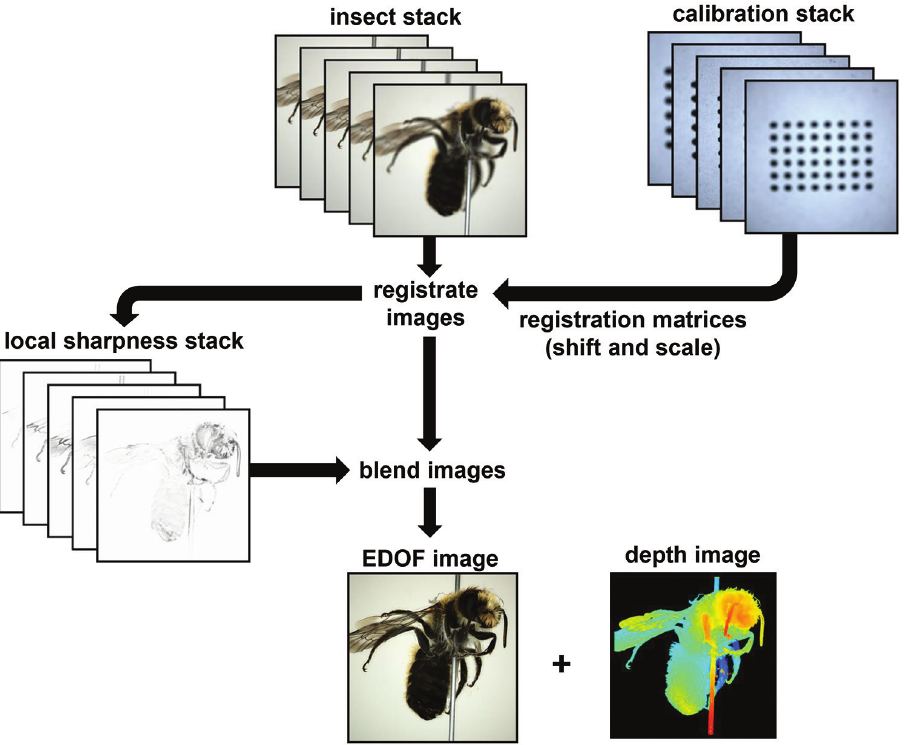
Figure 4. Workflow of EDOF-calculation. For a detailed description, see Suppl. material 1: S2.